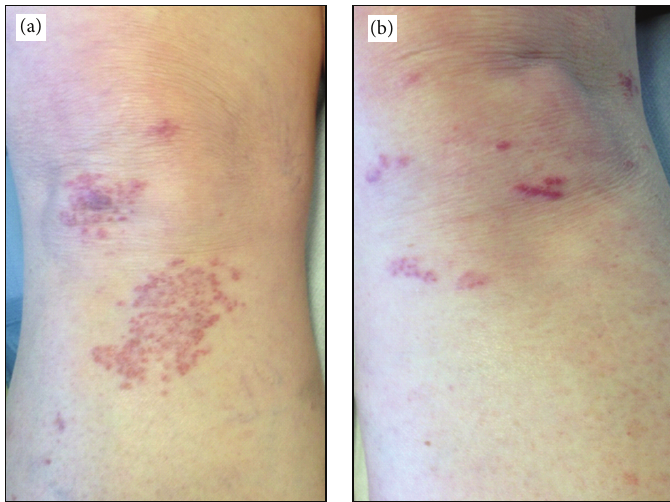
Figure 1: (a) Infiltrated, nonfollicular, lichenoid papules with a tendency to group, located on both knees; (b) a nearly complete remission of the lesions after 6-months therapy with topical 1% pimecrolimus.